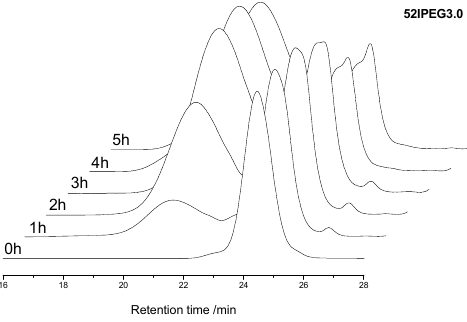
Figure 4. SEC spectra of 52IPEG3.0 with the time interval of 1 h.